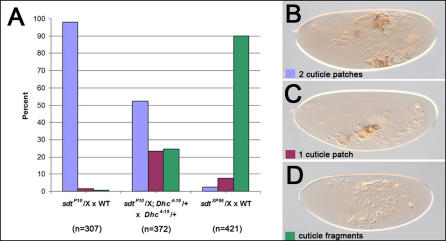

sdt Genetically Interacts with Dhc64C
(A) Graph quantifying the strong genetic interaction between sdt and Dhc64C, demonstrated by the cuticle phenotypes expressed by sdt embryos from three different genetic crosses. sdtP10 is a hypomorphic allele, which typically displays two patches of cuticle in addition to small cuticle fragments (B). In the strong sdtXP96 allele, the epidermis only produces small cuticle fragments (D). When Dhc levels are reduced in sdtP10 mutants, the cuticle in many embryos is reduced to a single patch (C) or strongly reduced to fragments, like sdtXP96 (D).